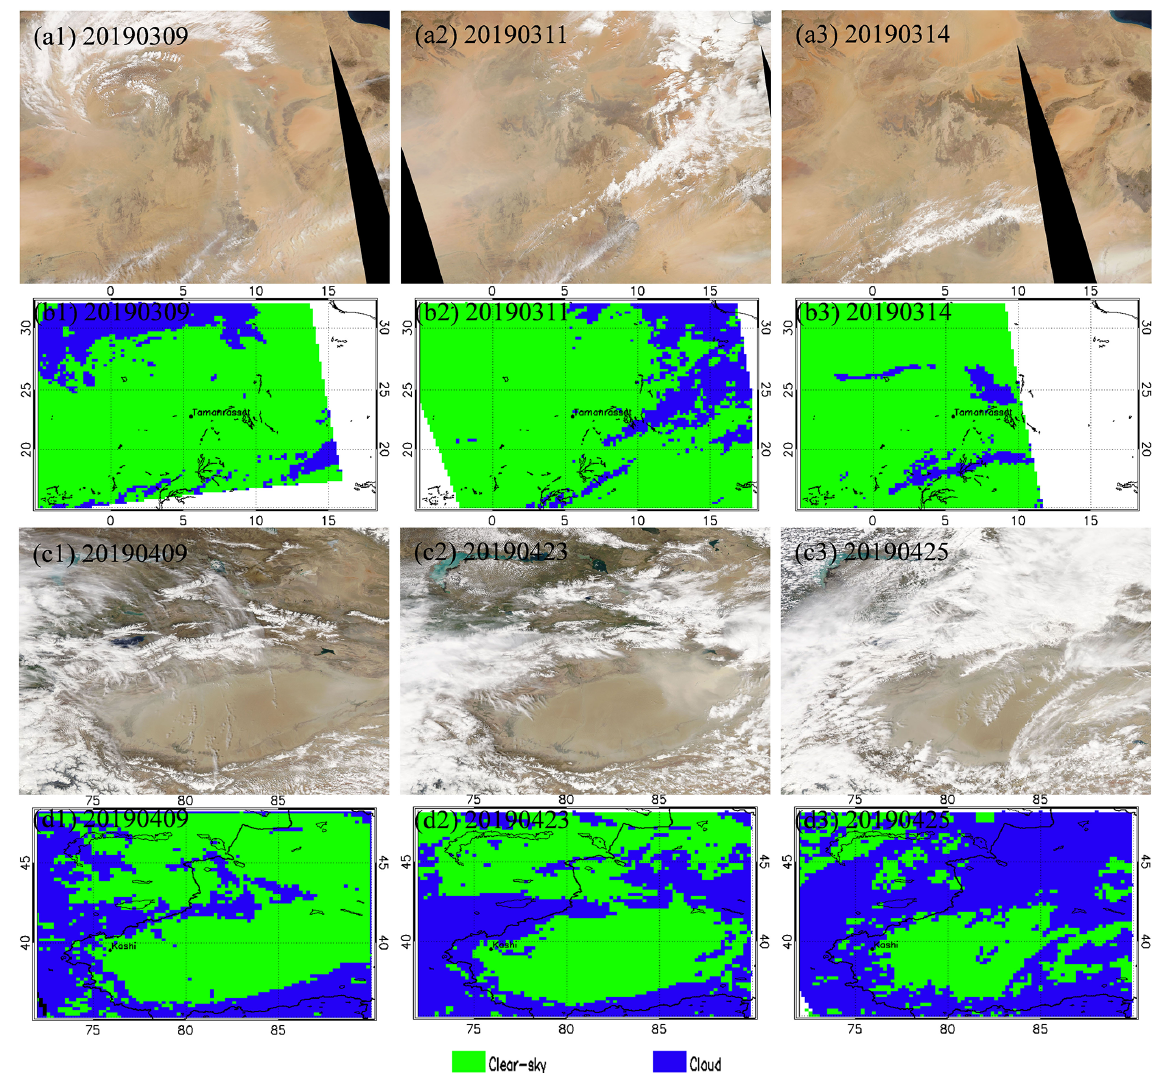
Figure 4. True color images and cloud detections from AQUA/MODIS